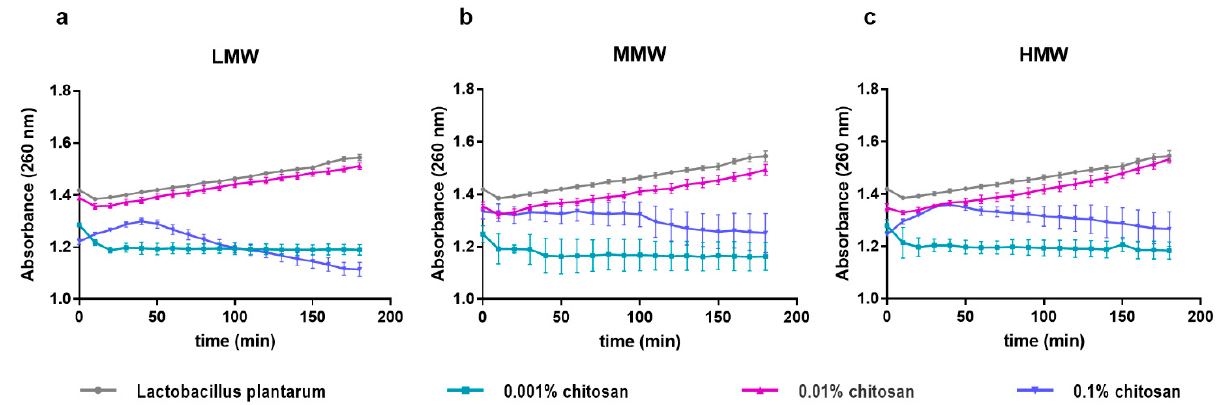
Figure 3. The release of cell content of L. plantarum was measured at 260 nm after treating with 0.001–0.1% concentration of LMW chitosan ( a ), MMW chitosan ( b ), and HMW chitosan ( c ).